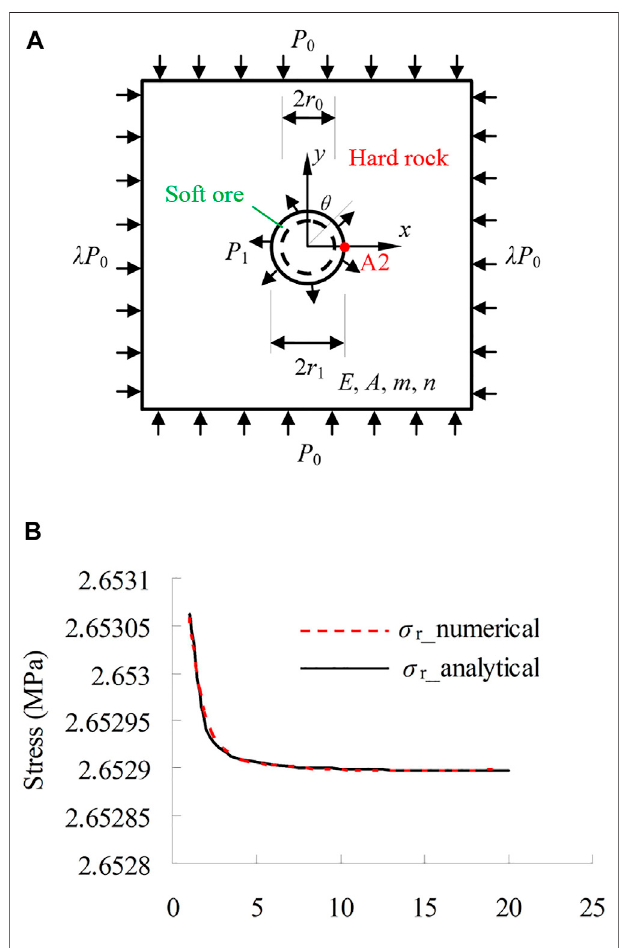
FIGURE 10 | The rheological shaft with interbedding structure. (A) Mechanical model; (B) Numerical model and comparison of numerical and theoretical results A2 ( x = 3.5, y = 0) for visco-elastic analysis.